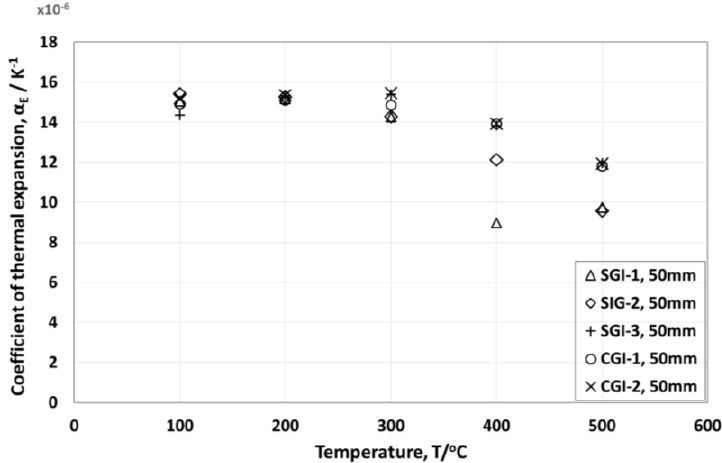
Figure 11. CTE of SGI-1, SGI-2, and SGI-3 (50 mm) and CGI-1 and CGI-2 (50 mm) as a function of temperature (during heating